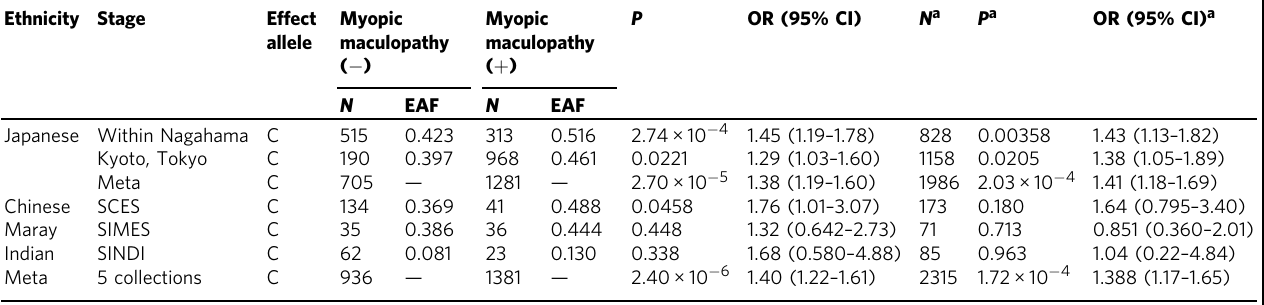
Table 2 Association of rs11873439 with myopic maculopathy in highly myopic eyes Ethnicity Stage